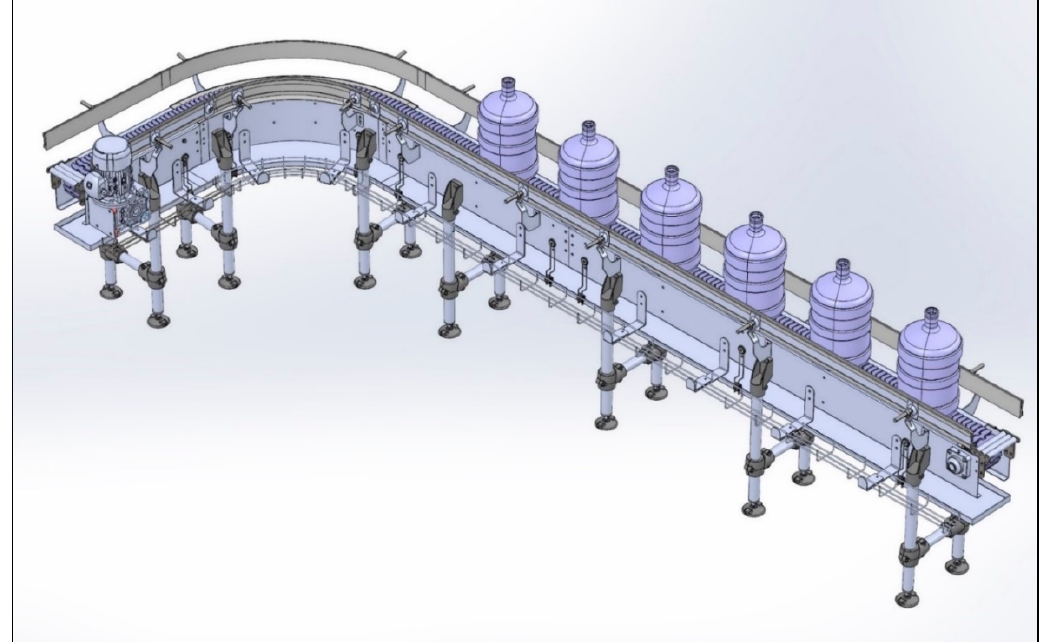
Figure 2. CAD model representing the TTC conveyor system.